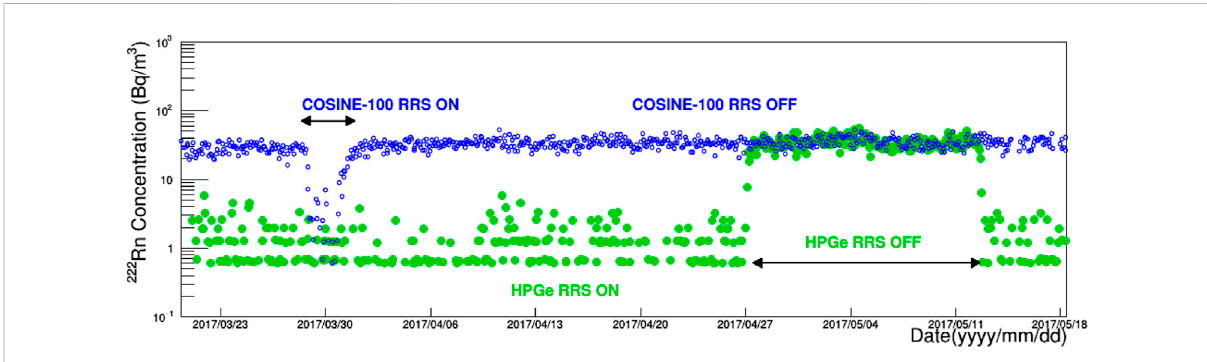
FIGURE 3 Comparison of two simultaneous A5 measurements of 222 Rn concentrations. A 2-month period comparison of A5 COSINE-100 (blue circles) and A5 HPGe (green dots) measurements is shown. When RRS air is supplied for A5 COSINE-100 (RAD7-1) at around 30/03/2017, the 222 Rn level drops as low as 0.6 Bq/m 3 . For A5 HPGe (RAD7-2), when RRS air is supplied, the level is on average 1.3 Bq/m 3 with standard deviation of 1.0 Bq/m 3 . When RRS is stopped for 2 weeks starting from 27/04/2017, the measured concentration reaches to the level of 34.2 ± 0.6 Bq/m 3 which is